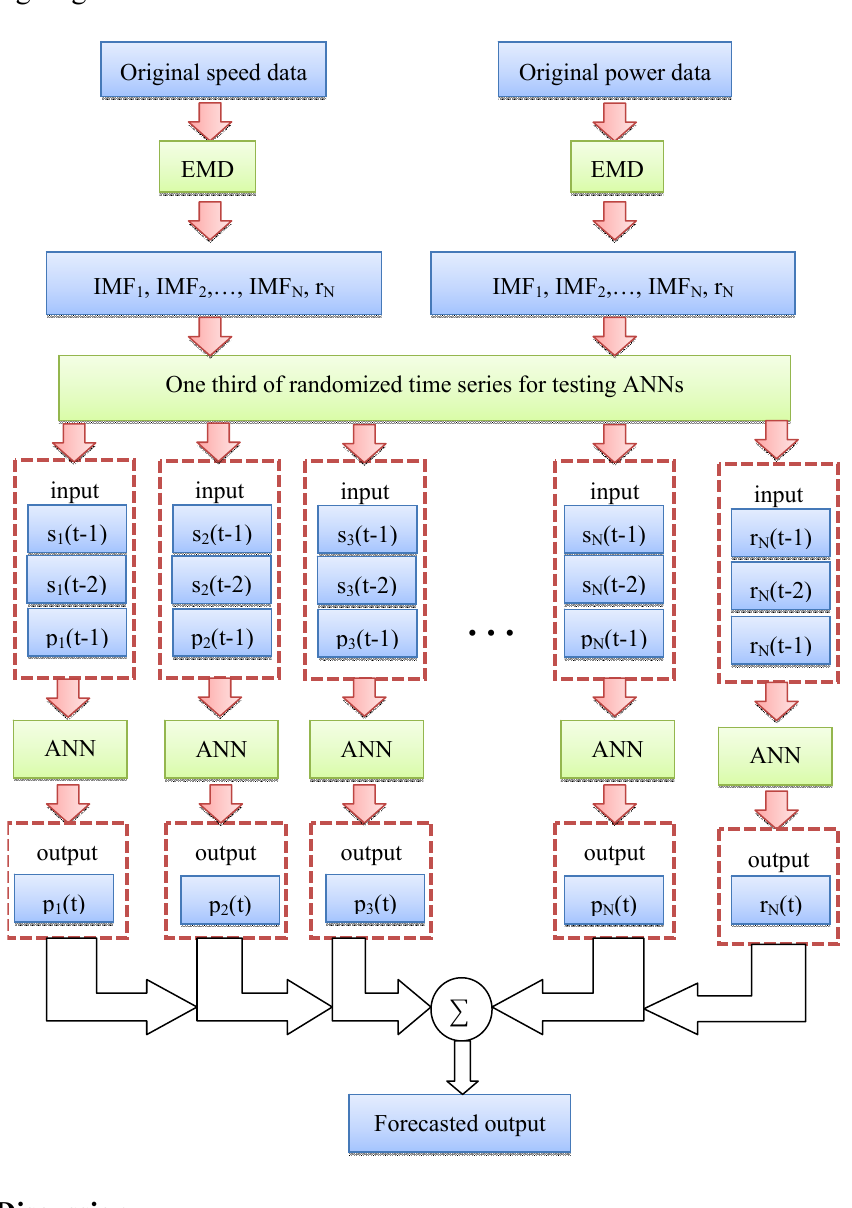
Figure 3. pi(t) forecasting using identified parameters at times t-1 and t-2 as inputs in the ANN testing